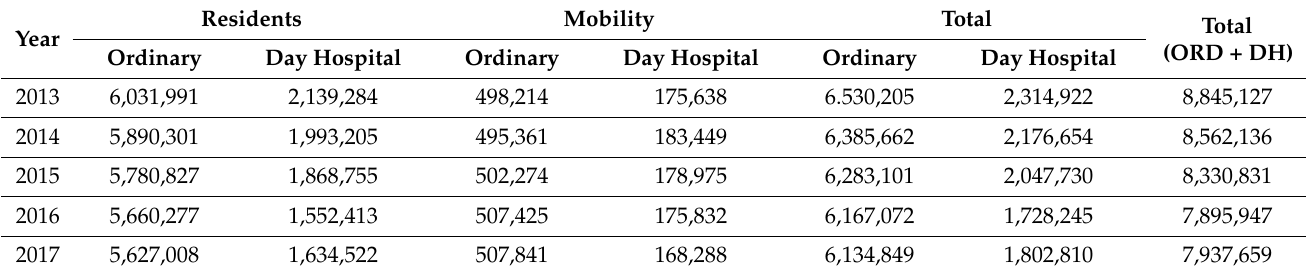
Table 1. Admissions of acute patients to Italian hospitals,